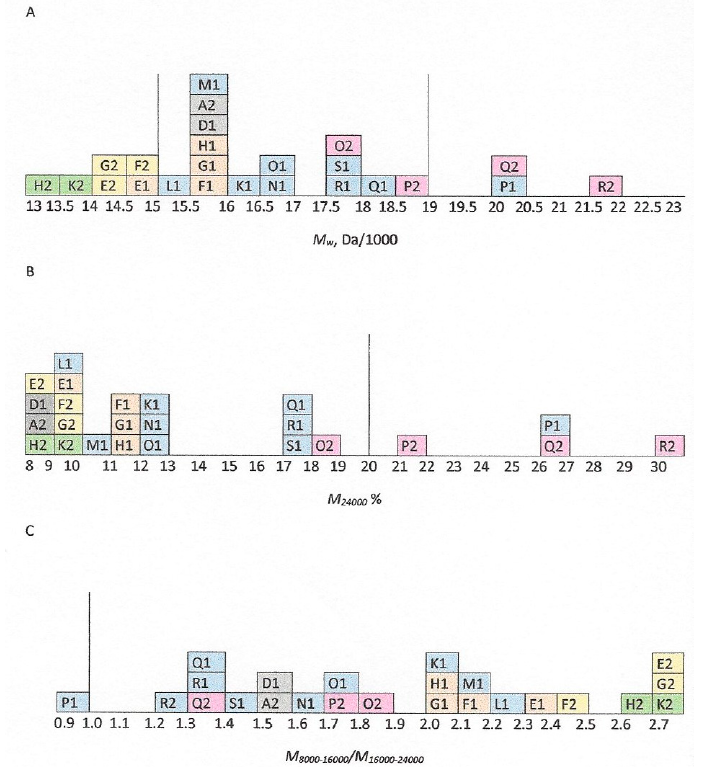
Figure 1. Histogram plots of Phase 1 summary results for 24 heparin samples (see Table S1) ( A ) M w , ( B ) M 24,000 and ( C ) M 8000–16,000 / M 16,000–24,000 for bovine lung heparin (green), porcine mucosal heparin (grey), and bovine mucosal heparin from sample donors 1 (orange), 3 (blue), 4 (pink), and 6 (yellow). Values recorded are the mean values from five or six laboratories (see Table S2A–C) The vertical lines indicate upper and lower limit acceptance criteria in the USP monograph for heparin sodium.